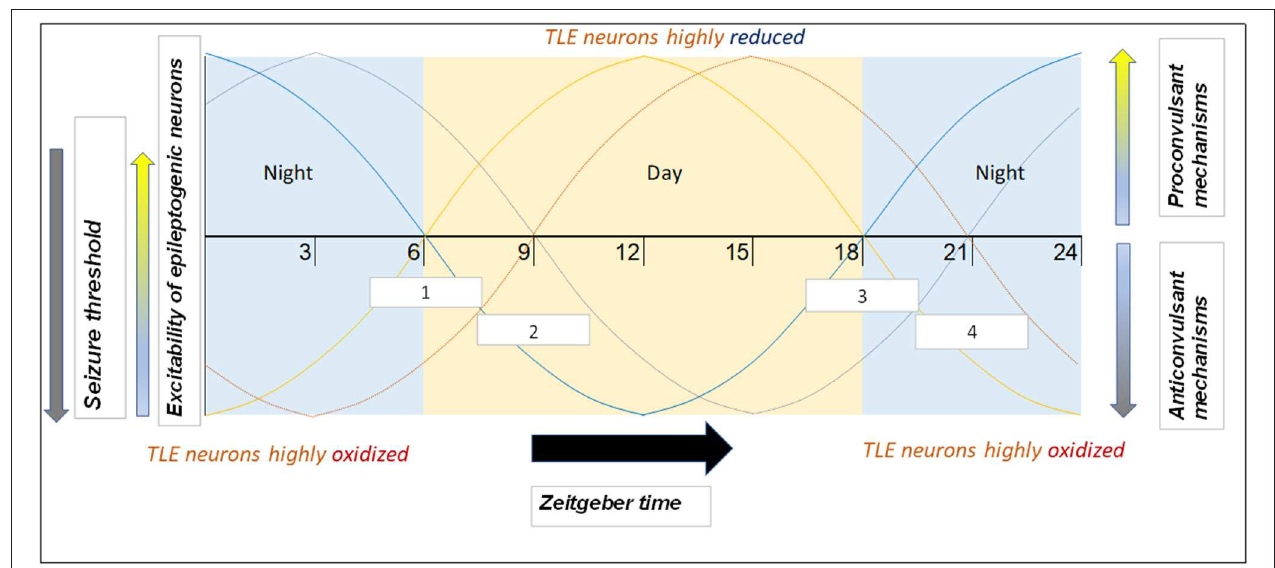
FIGURE 3 | Example of how phenotype and chronotype permit implementation of chronotherapy for epilepsy, along with potential mechanisms responsible for time-based seizure susceptibility. This depiction portrays likely patient circadian (daily) seizure threshold/neuronal excitability patterns. Zeitgeber times are on the x-axis. Of the four “sample patients” illustrated, two have a morning chronotype (morning larks; curves depicted in lighter hues) and two have an evening chronotype (night owls; curves depicted in darker hues). Two suffer from focal seizures originating in the temporal lobe (orange hues) and seizures in the two others originate in the frontal lobe (blue hues). Since seizures are most likely to occur during the mid-day (12–15) and night (24–3) for temporal and frontal lobe epilepsies, respectively ( 9), therapeutic drugs may be best suited to be administered soon before the high seizure tendency time window (white boxes). Boxes 1 and 2 (corresponding to light orange and dark orange curves, respectively) represent AED time administration windows for TLE patients with morning and evening chronotypes, respectively. Boxes 3 and 4 (corresponding to light blue and dark blue curves, respectively) represent time windows for frontal lobe epilepsy (FLE) patients with morning and evening chronotypes,